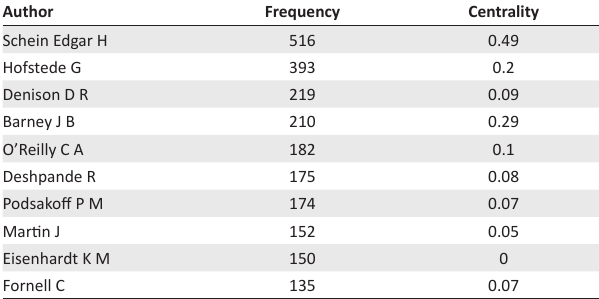
FIGURE 11: Map of references: cluster view. Restricting reference years from 2000 to TABLE 9: The Top 10 authors of reference articles.